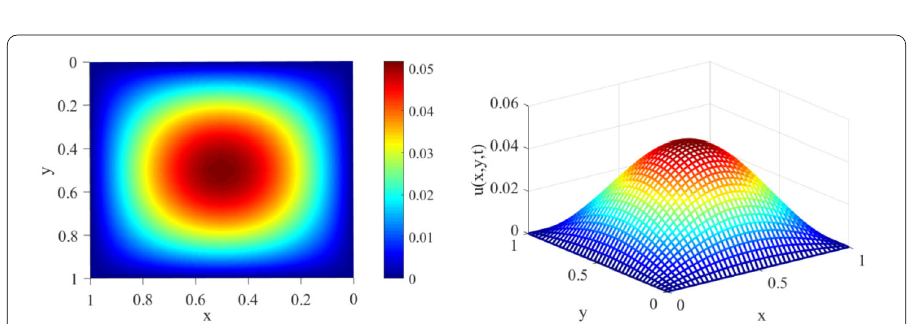
Figure 21 The slices of the four-dimensional figures of the solution of the three-dimensional problem for z = 0.5 (on left-hand side figure), and a three-dimensional figures of the solution of the three-dimensional problem at t = 0.1 with z = 0.5 (on right-hand side figure) for Example 6